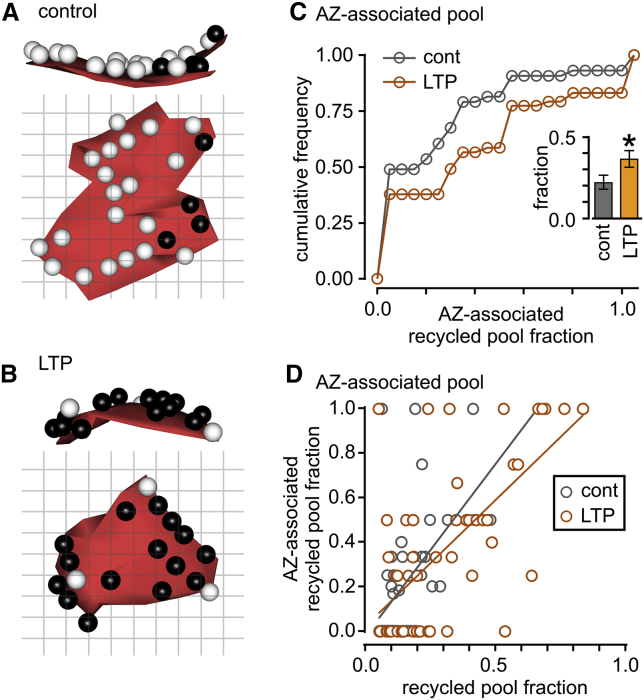
Increased Residency of Functionally Recycled Vesicles in the Active Zone-Associated Pool after LTP(A and B) Example 3-d reconstructions of active zones (az) for control (A) and LTP synapses (B). Dark spheres are recycled pool vesicles. Top panel: side view (cross-section); bottom panel: face view from terminal looking toward dendrite.(C) Cumulative frequency distribution plot showing recycled pool fraction in active zones for control (n = 43 synapses) and LTP synapses (n = 52 synapses). Inset shows mean recycled fraction ± SEM.(D) Scatterplot of the recycled fraction in the AZ-associated pool versus the recycled pool fraction of all vesicles for control (gray; n = 43 synapses; Spearman correlation ρ = 0.60, p < 0.001) and LTP (orange; n = 52 synapses; Spearman correlation ρ = 0.58, p < 0.001).